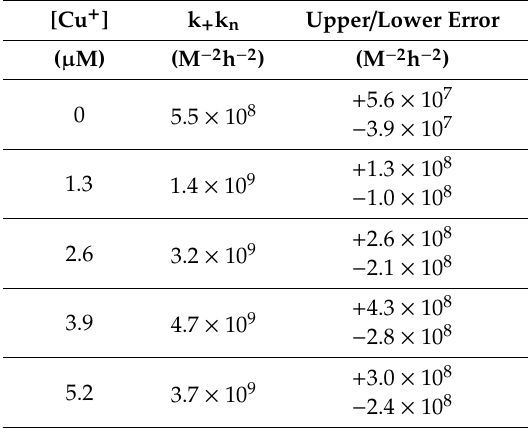
Table 2. Rate constants for A β (1-42) aggregation in presence of Cu + . Rate constants were determined by fitting unseeded kinetic data and setting the combined rate constant k n k + as the dependent variable and the combined rate constant k 2 k + as a globally fitted fixed parameter (e.g., primary nucleation + 6.8 × 1016 − 3 − 2 h catalysis). The fitted value for k + k 2 was 4.9 × 10 18 . The upper / lower errors define the − 1.1 × 1017 M interval in which the rate constant variation does not significantly change the goodness of fit [85]. 13 of 19 [Cu + ] k + k n Upper / Lower Error ( µ M) (M − 2 h − 2 ) (M − 2 h − 2 ) data using a model for Cu 2+ -dependent variation in the combined rate constant for primary nucleation and elongation (k n k + ).